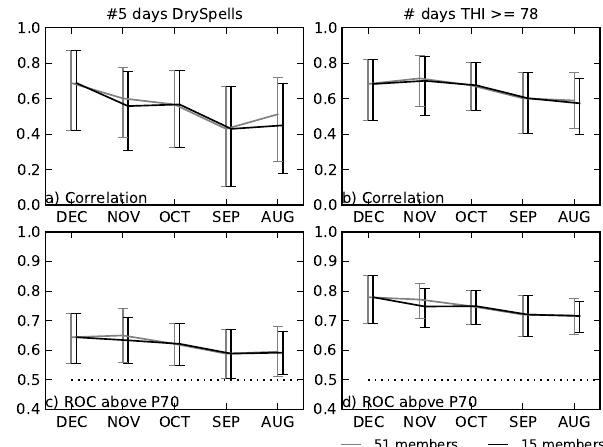
Fig. 7. Seasonal forecast scores over the Limpopo region valid for DJF, at different lead times, for the frequency of occurrence of 5- day dry spells (a, c) and frequency of occurrence of days with THI higher than 78 (b, d) . Mean grid-point correlation (a, b) and ROC of the forecast anomalies above the upper tercile (c, d) . The error bars denote 95% confidence intervals estimated from 1000 boot- strap samples. The dark lines show the scores using the 15 ensem- ble members. The gray lines show the scores when using the full 51 ensemble members in the hindcast period (only available for the November and August initial forecast dates, for the other forecasts, the gray lines show the same as the dark